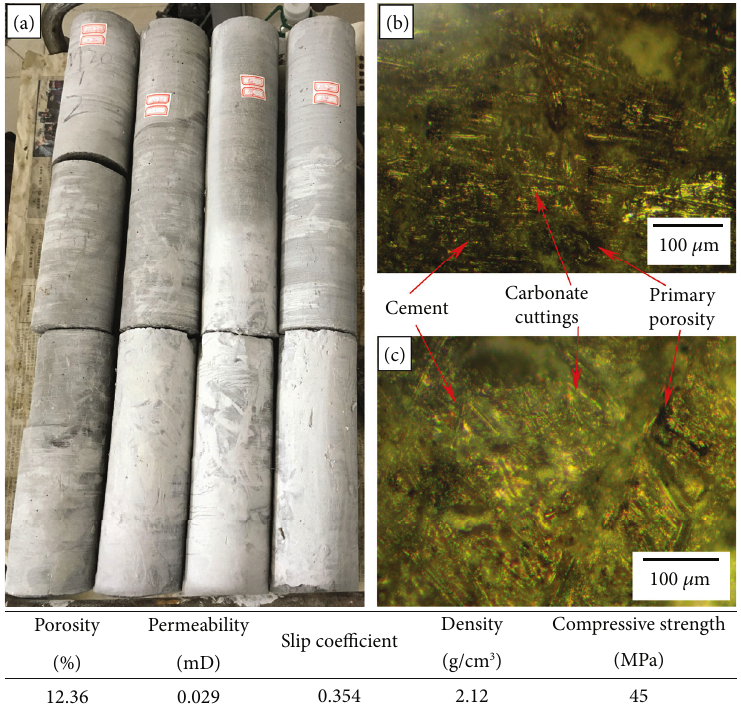
Figure 3: The physical property (porosity, permeability, slip coe ffi cient, density, and compressive strength) of the cores from the borehole models. (a) The diameter and length of the extracted cores are 76 mm and 600mm. (b, c) The metallurgical map of the